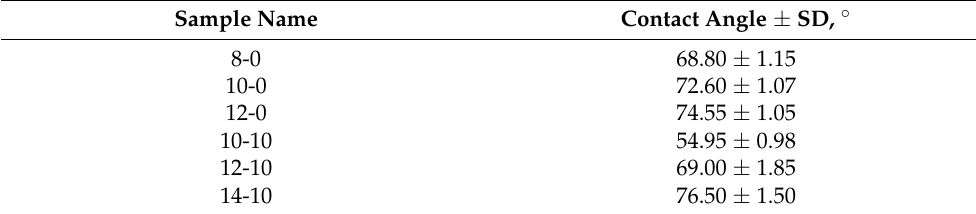
Figure 6. Images presenting the wettability of hydrogels towards distilled water. Table 4. Values of contact angles of tested